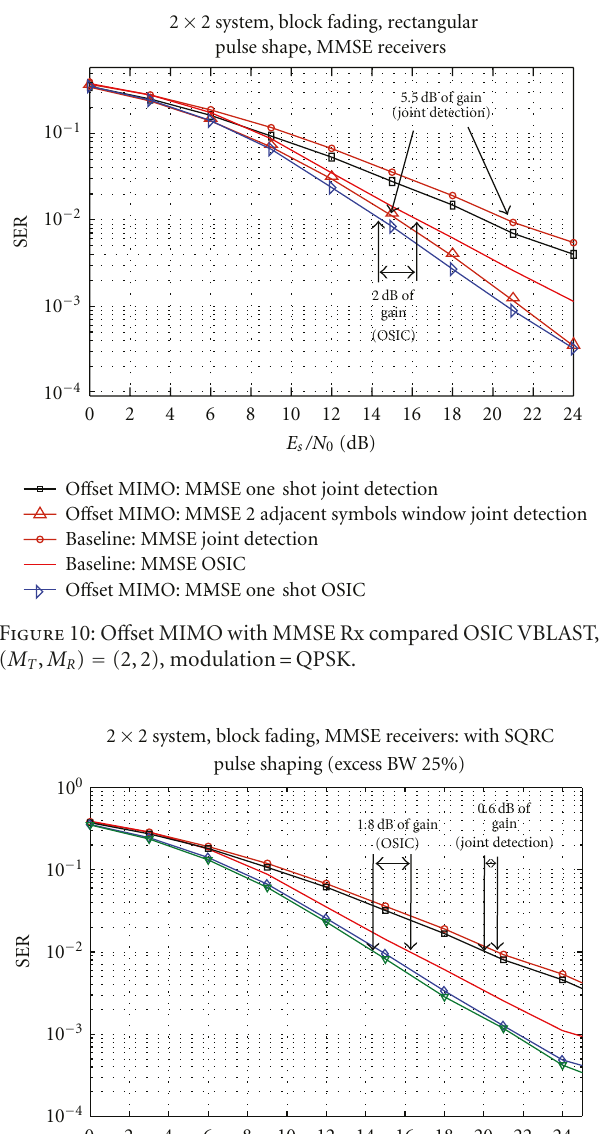
cosine pulse shaping with 25% excess bandwidth is shown in Figure 11. The square root raised cosine (SRRC) filters on the transmitter and receiver sides have both been truncated to 13 symbols.